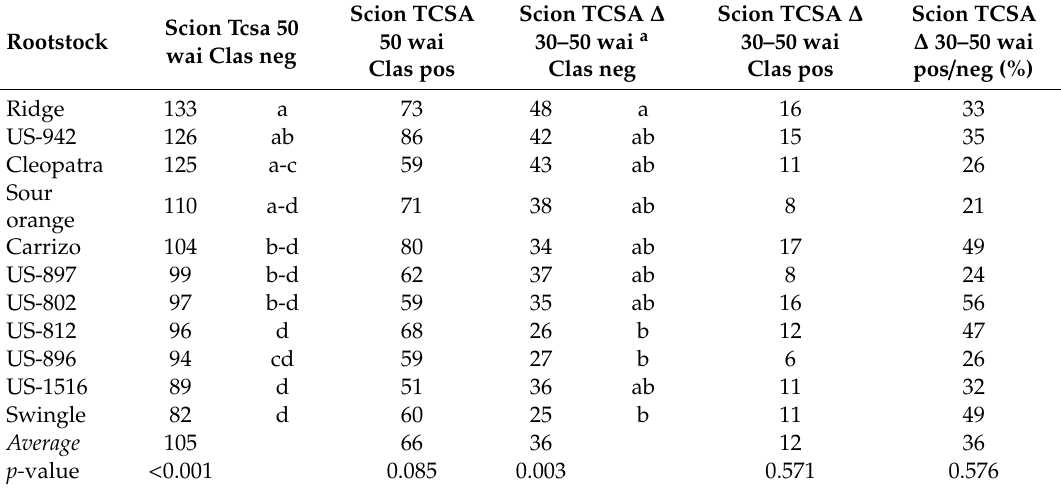
Table 4. Scion size and growth, as trunk cross-sectional area (TCSA) in mm 2 .